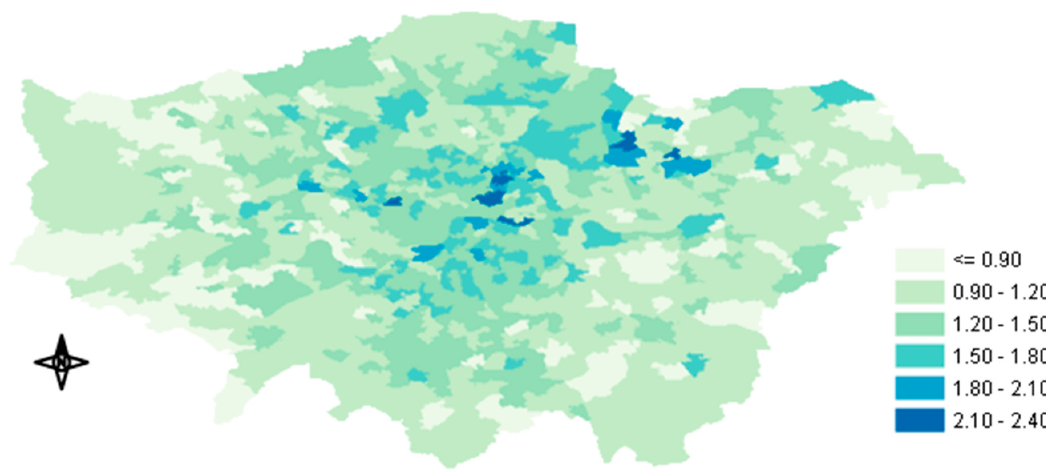
Figure 5. Spatial distribution of the predicted change in the estimates of mortality burden misclassification (in death cases) between Tier model 1 and Tier model